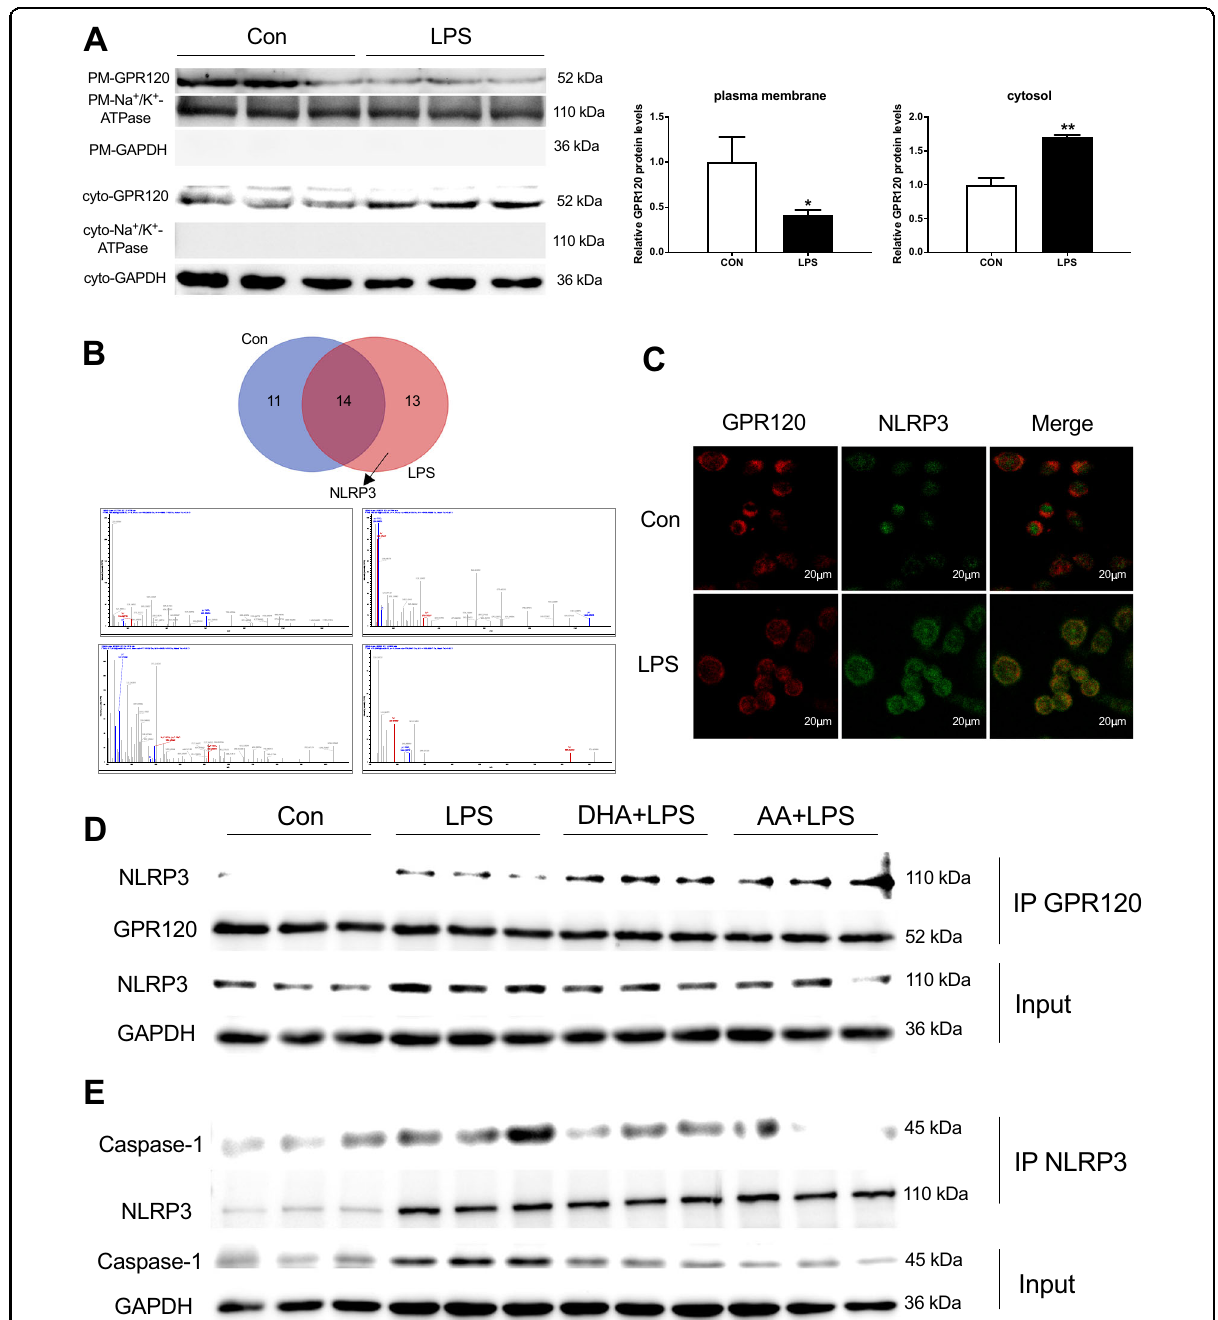
Fig. 4 DHA/AA promoted the interaction between GPR120 and NLRP3 in LPS-induced Kupffer cells. Kupffer cells were treated with 100 ng/mL LPS for 12 h. A The GPR120 protein expression in the plasma membrane and cytoplasm. B The expression of NLRP3 protein was observed by the Venn diagram and LC-MS/MS analysis (the upper image is the Venn diagram and the lower one is the NLRP3 mass spectrogram). C GPR120 and NLRP3 co-localization was observed in immuno fl uorescence (scale bar, 20 μ m); D , E Kupffer cells were pretreated with 50 μ M DHA/AA for 4 h and then treated with 100 ng/mL LPS for 12 h. The cell lysates were immunoprecipitated with GPR120 antibody and NLRP3 antibody separately, and then the samples were analyzed by western blot for GPR120, NLRP3, and caspase-1 as indicated in the text. In the bar graph, data represent the means ± SEM, n = 3 per group. ** P < 0.01 and * P <